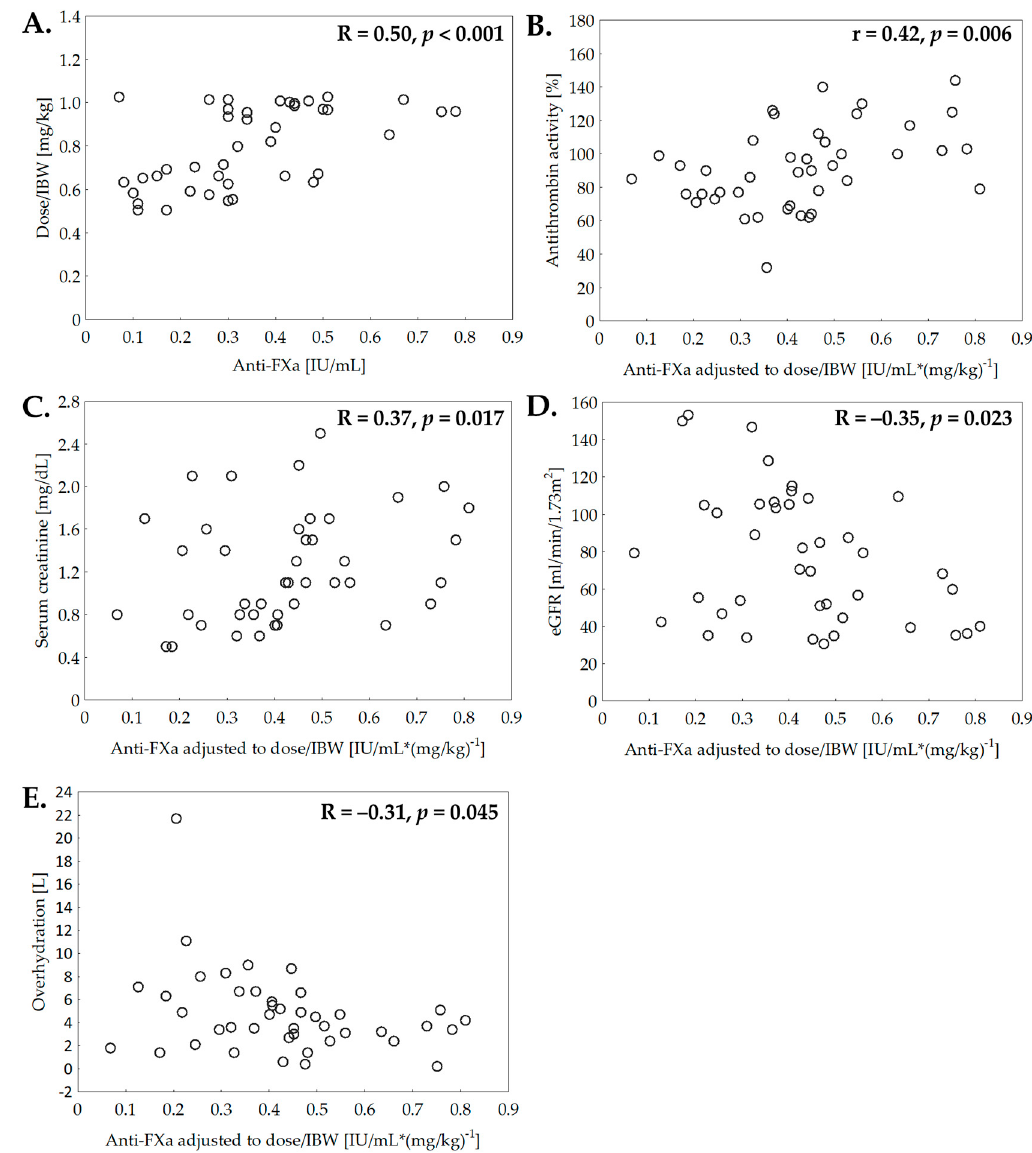
Figure 3. Correlations between enoxaparin concentration and clinical and laboratory m asures in severe nephrotic syndrome: dose/IBW ( A ), antithrombin activity ( B ), serum creatinine ( C ), eGFR ( D ) and overhydration ( E ). R—Spearman rank correlation coefficient, r—Pearson correlation coefficient.